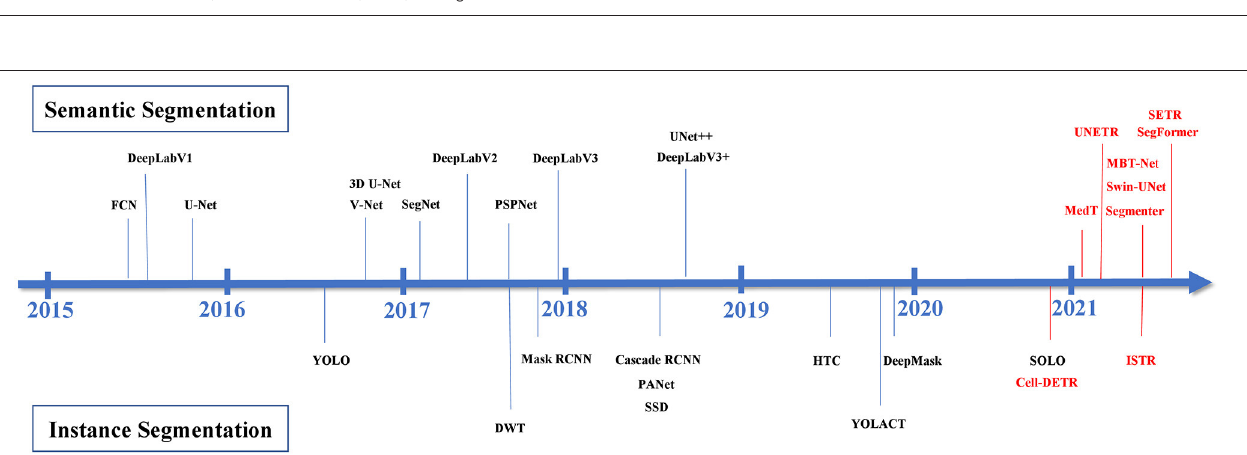
boundaries of different categories, such as the boundaries